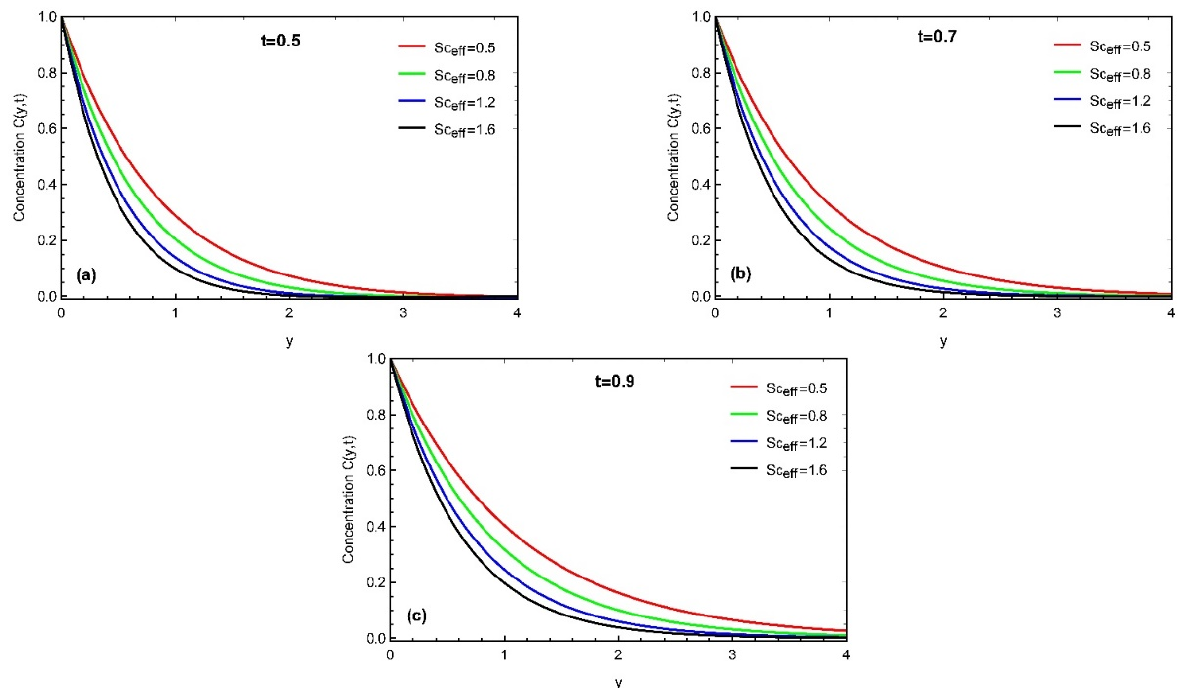
Figure 5. Variation in concentration due to Schmidt number at ( a ) 𝑡 = 0.5 ( b ) 𝑡 = 0.7 ( c ) 𝑡 = 0.9 .